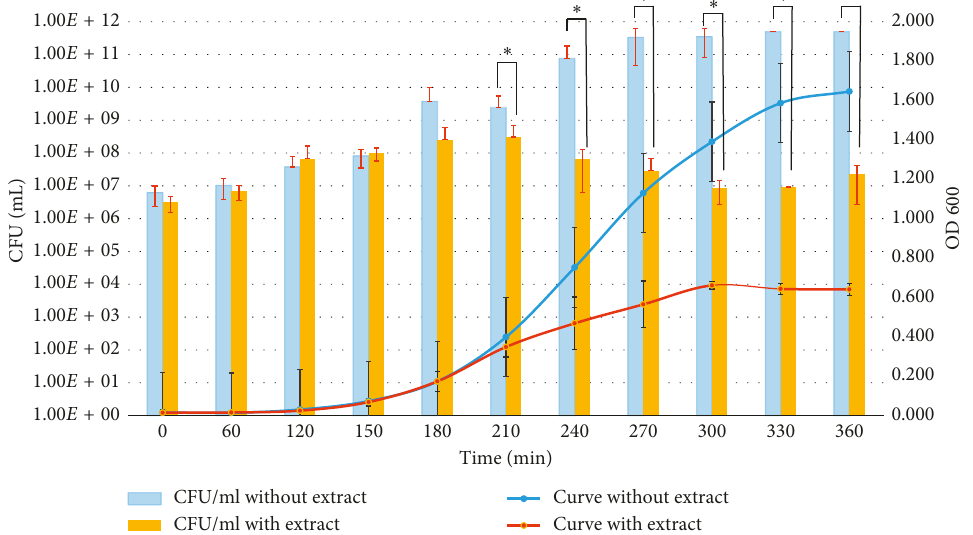
Figure 2: Growth curve and count of colony-forming units of clinical strains of Staphylococcus aureus . The light blue bars correspond to the colony count without the extract of Luma apiculata 1mg/mL. The yellow bars correspond to the colonies count with Luma apiculata extract of 1mg/mL. In blue, the curve without extract of Luma apiculata is observed. In red, the curve is observed with extract of Luma apiculata of